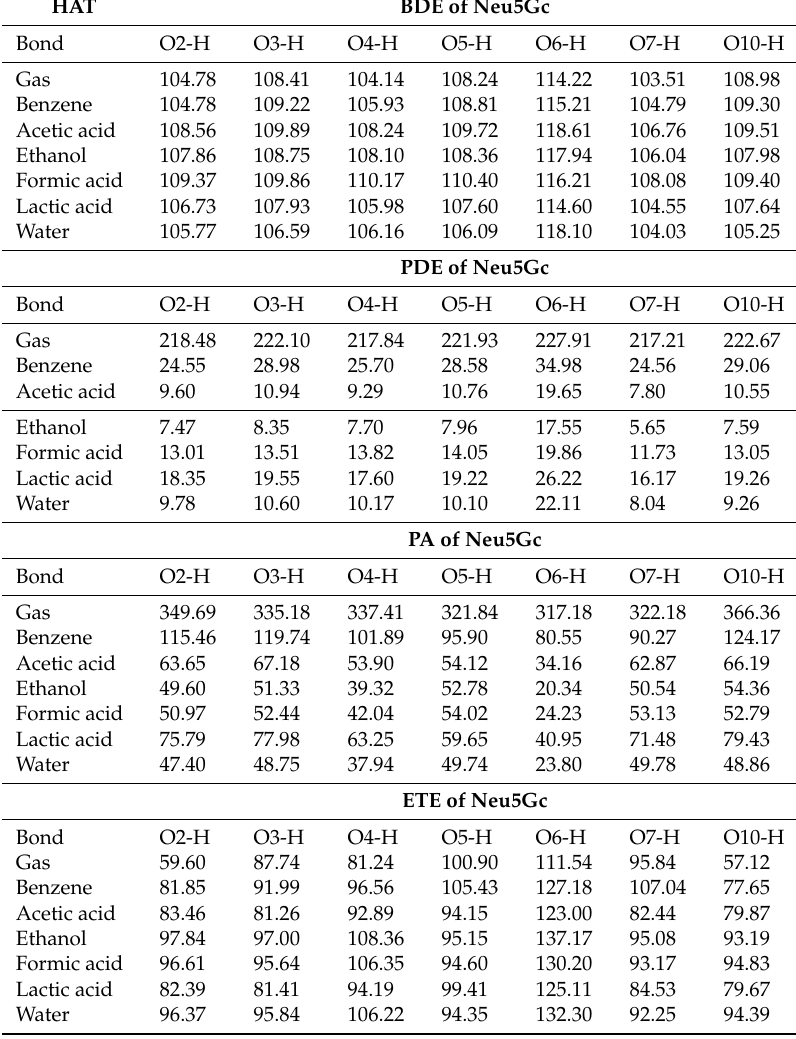
Table 5. Antioxidant mechanism parameters of Neu5Gc. (optimized and thermal correction to enthalpy at the M062X/6-311 + G(d,p) level, single point energy at the M062X/def2TZVPPD level,